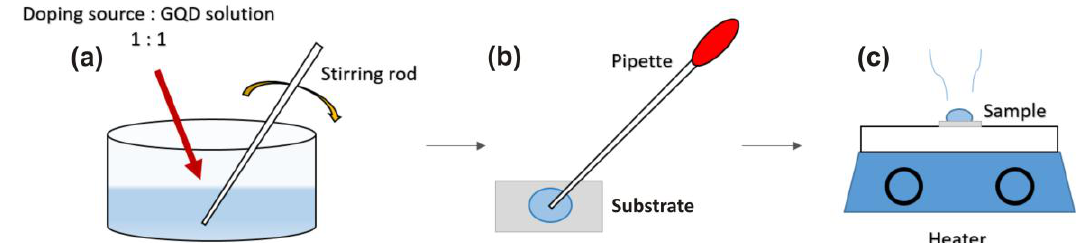
Figure 1. Sample preparation method: ( a ) Graphene quantum dots (GQDs) mixed with reduced dopants in 1:1 amount and stirred; ( b ) Doped GQDs solution drop casted on substrate; and ( c ) substrate heated on hot plate at 85 °C for 10 min.